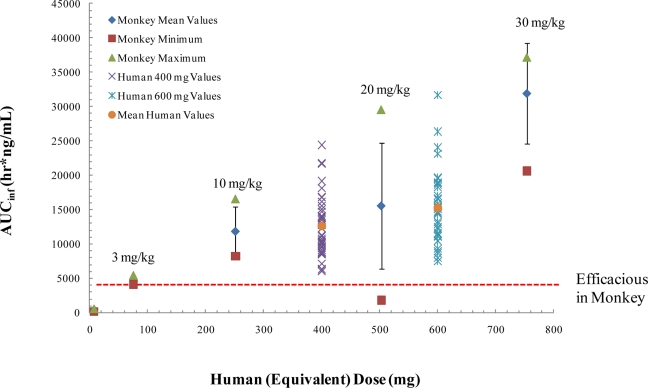
A comparison of ST-246 exposure (area under the concentration time curve, AUC) in monkeys and humans. Monkey doses were converted to human equivalent doses by multiplying first by 0.32 in accordance with FDA Guidance for Industry (entitled Estimating the Maximum Safe Starting Dose in Initial Clinical Trials for Therapeutics in Adult Healthy Volunteers, published July 2005) and then multiplying by the average weight of human (78.6 kg) from the clinical study. The maximum, minimum and mean AUC for monkeys is shown in the green triangles, brown squares, and blue diamonds, respectively. The range in AUC values in humans is indicated by the symbols. The red dashed line indicates the dose of ST-246 that protects non-human primates from lethal infection.